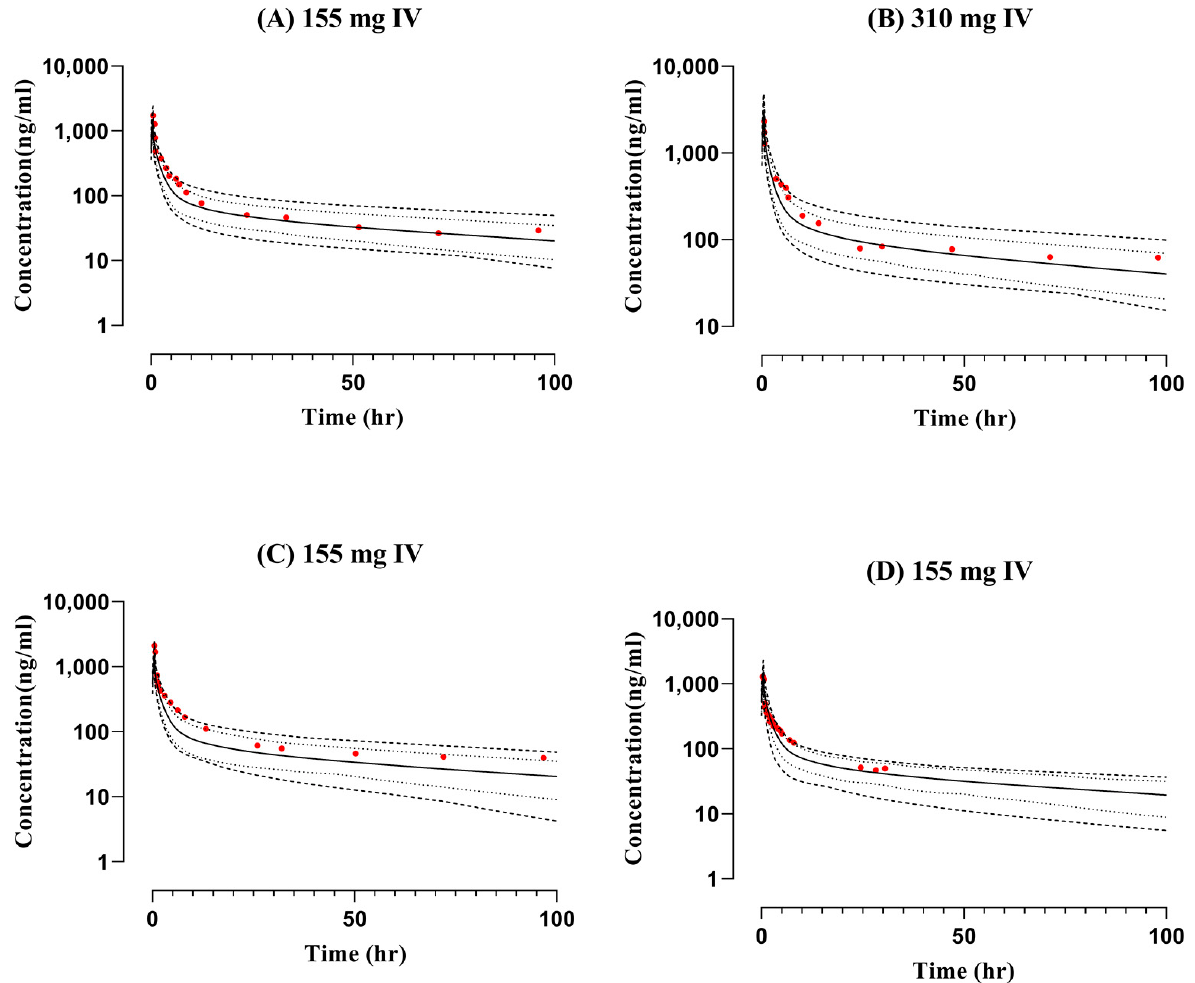
Figure 2. Comparison of observed and predicted blood-concentration–time profiles after intravenous administration of doses ( A ) 155 mg [9], ( B ) 310 mg [9], ( C ) 155 mg [6], ( D ) 155 mg [29]. Solid lines are presented as mean, dashed lines as minimum, maximum, dotted lines as 5th–95th percentile and red-filled circles as observed data.